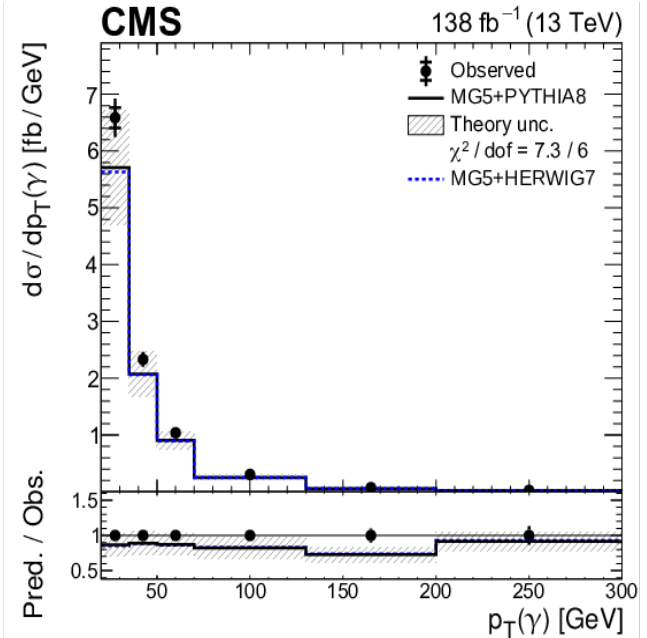
Figure 21. Distribution of the absolute production cross-section of t¯t γ in the dilepton channel as a function of the p T of the photon, as measured by the CMS experiment [48]. Observed data unfolded to particle level is compared with the predicted distribution from the Madgraph generator with two different parton shower models. Theoretical uncertainties evaluated using the Pythia 8 prediction are shown in the shaded grey